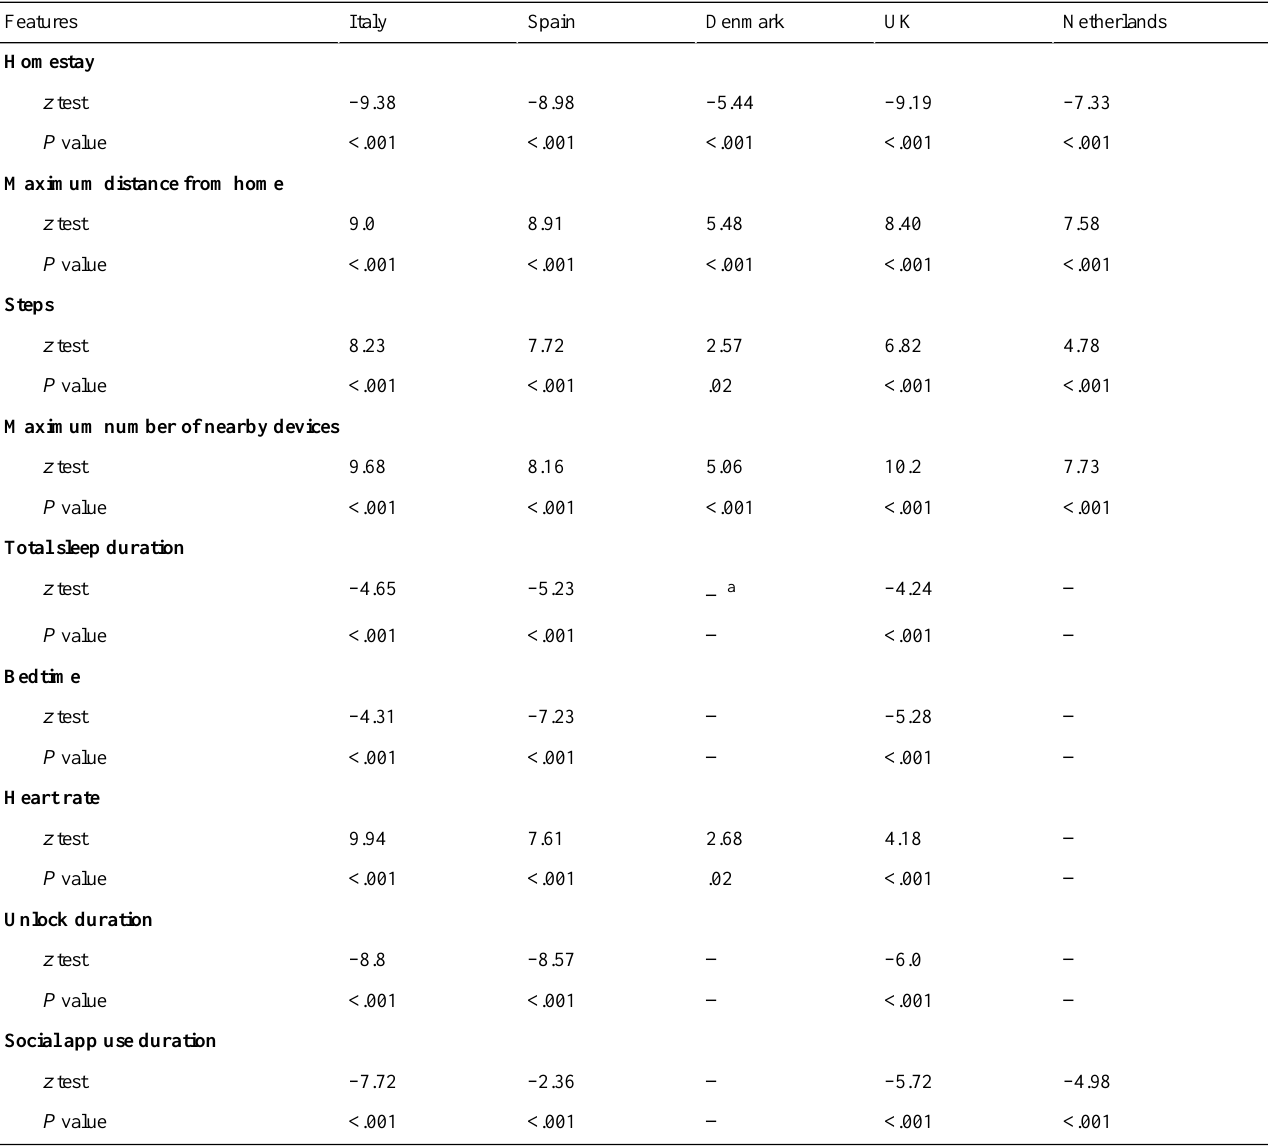
Table 2. Results of post hoc Dunn test (after Kruskal-Wallis tests) on the extracted features between prelockdown and during lockdown periods (only statistically significant differences were reported).